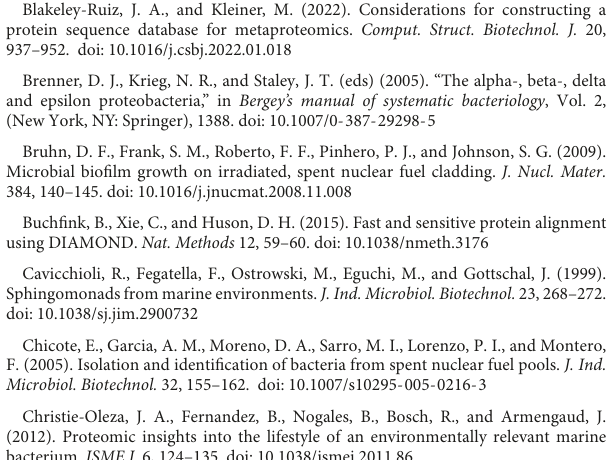
SUPPLEMENTARYFIGURE1 Heatmaps based on NGOAF results with row scaling, representative of functional differences between sampling sites for both Caulobacter and Sphingomonas